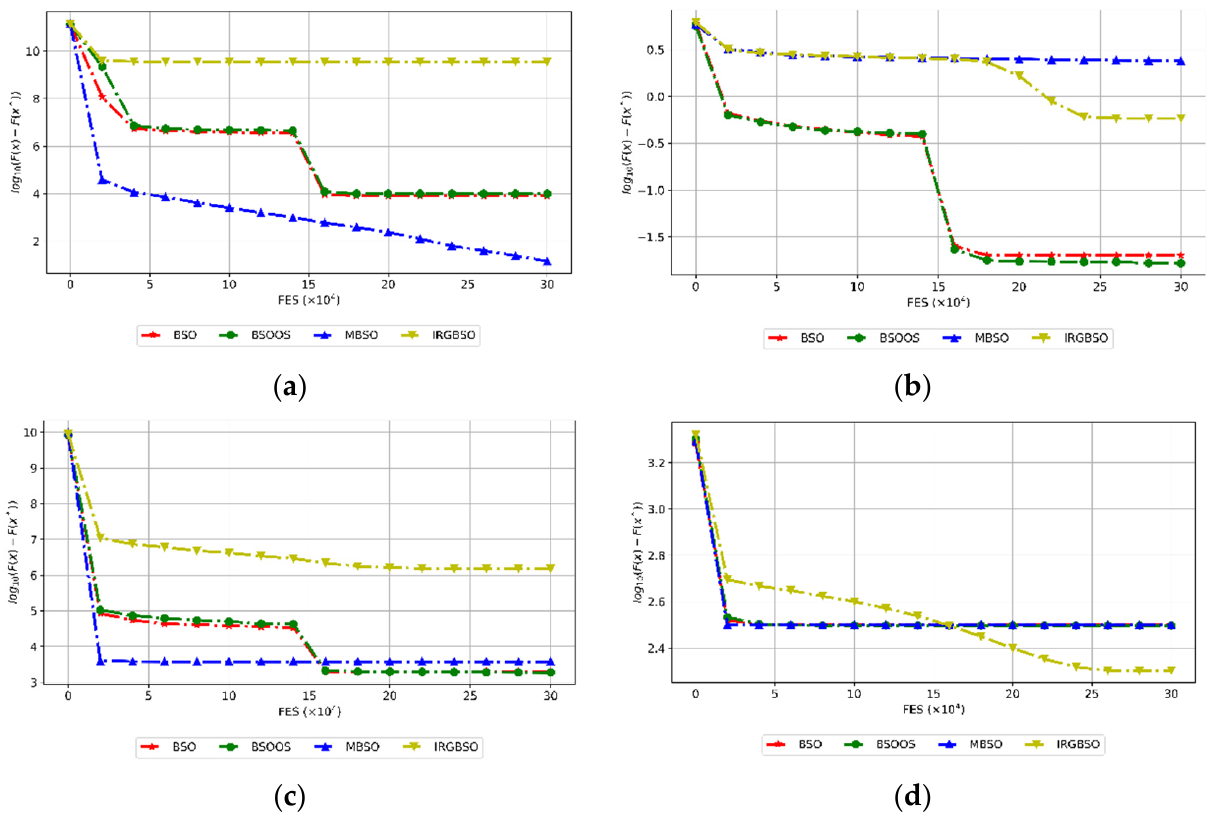
Figure 1. Evolution of the mean errors (in logarithmic scale) of BSO, MBSO, IRGBSO, and BSO-OS versus the number of FES on four test problems. ( a ) F 2 ; ( b ) F 12 ; ( c ) F 18 ; ( d ) F 23 .